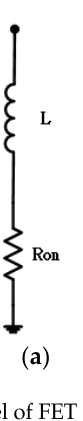
Figure 3. The simplified small signal model of FET switches.: ( a ) ON-state model; ( b ) OFF-state model.